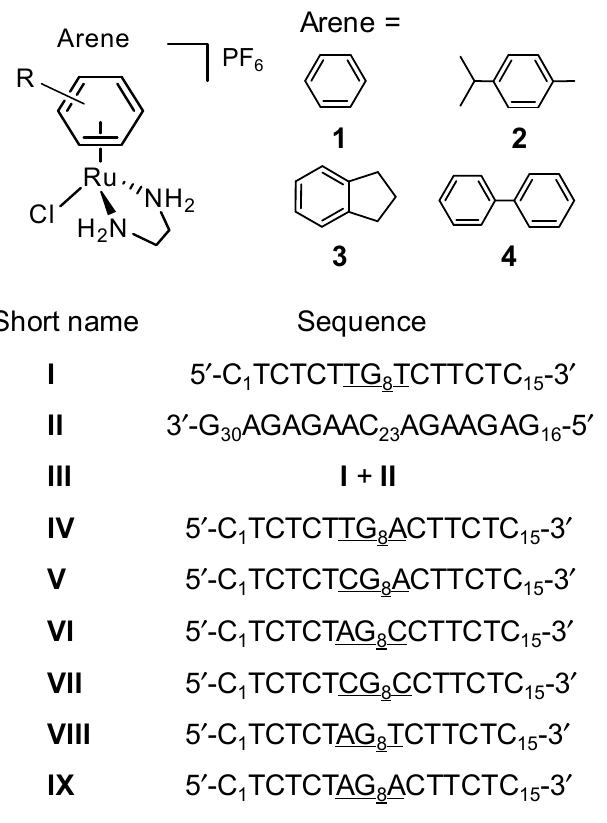
Chart 1. Structures of ruthenium arene anticancer complexes and sequences of oligodeoxynucleotides (ODNs) used in this work. ODNs IV – IX are the analogues of strand I with only variations at the neighboring bases of the central guanine (underlined).